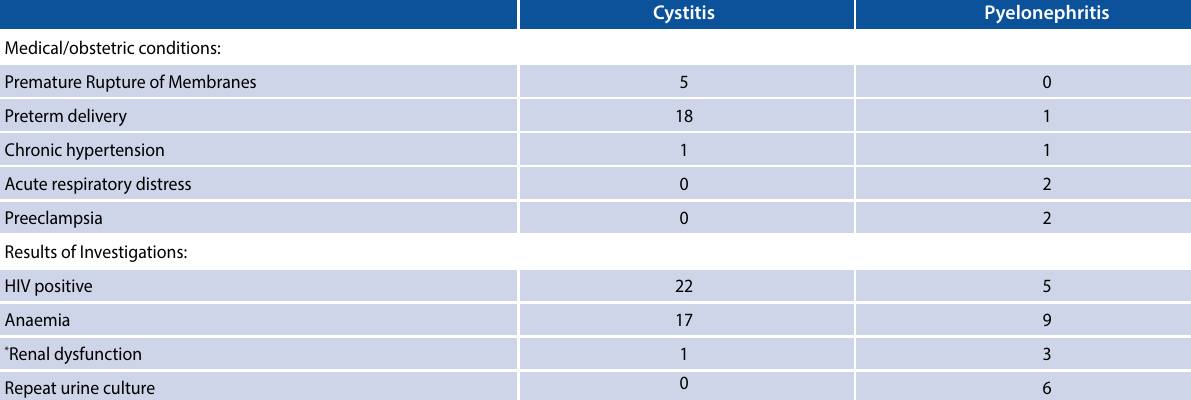
* Transient renal dysfunction